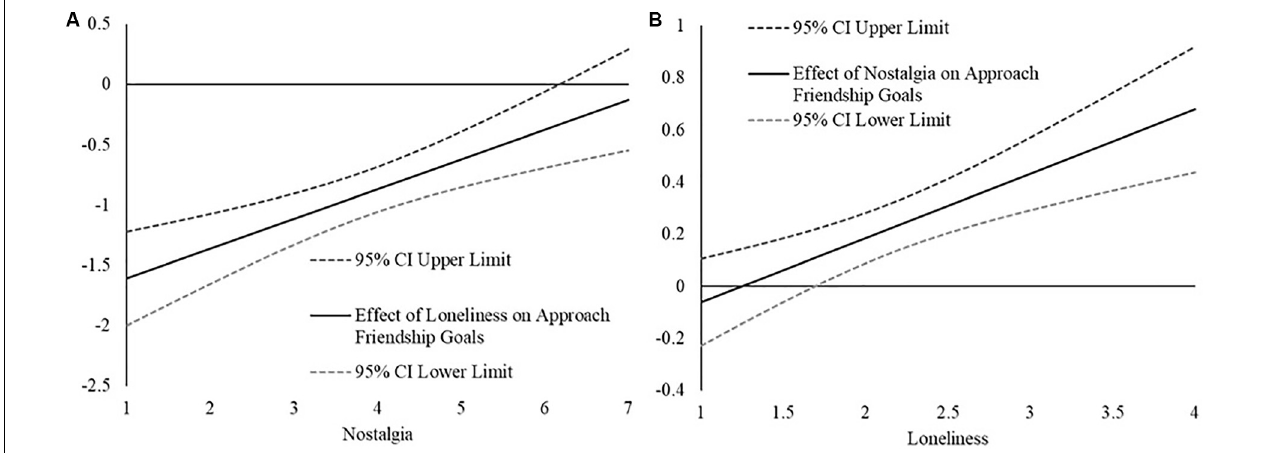
FIGURE 2 | (A) The plot represent; the estimated relation between loneliness and approach-oriented friendship goals ( y -axis) across the range of nostalgic feeling; ( x -axis) in Study 2. The relation; are considered statistically significant if the confidence intervals for the effect (Cl) do not contain 0. (B) The represents the estimated relation between nostalgic feelings and approach- oriented friendship goals ( y -axis) across the range of loneliness scores ( x -axis) in Study 2. The relations are considered statistically significant if the confidence intervals for the effect (Cl) do not contain